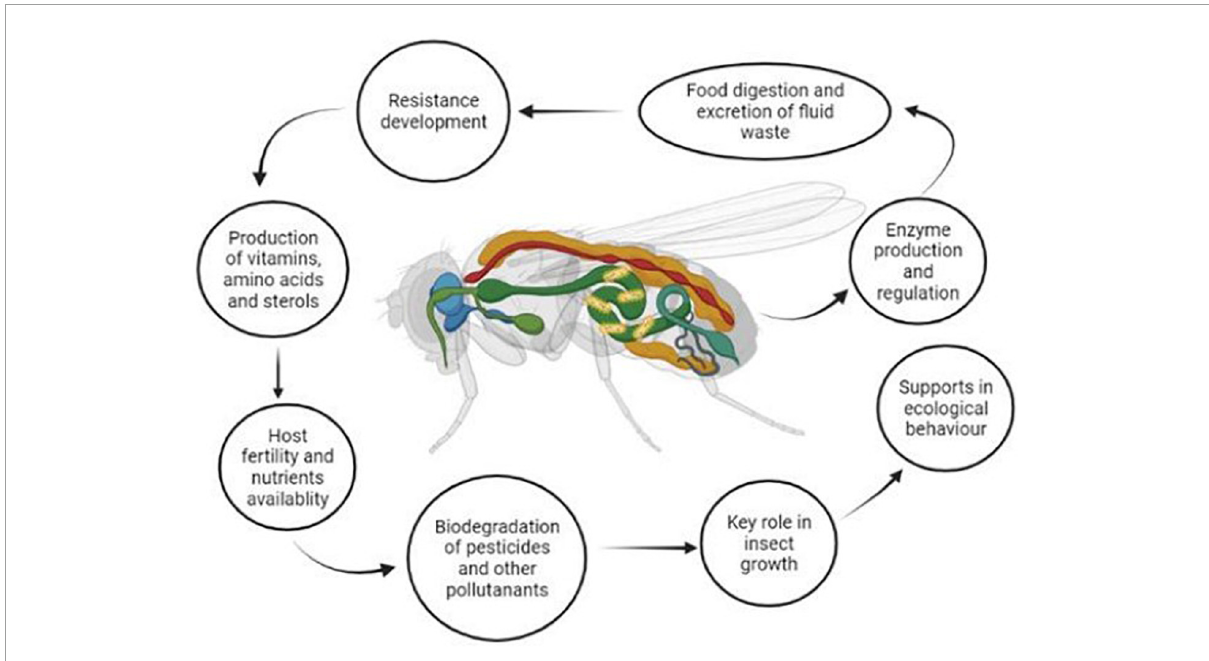
FIGURE1 Role of insect gut microbiota in insect